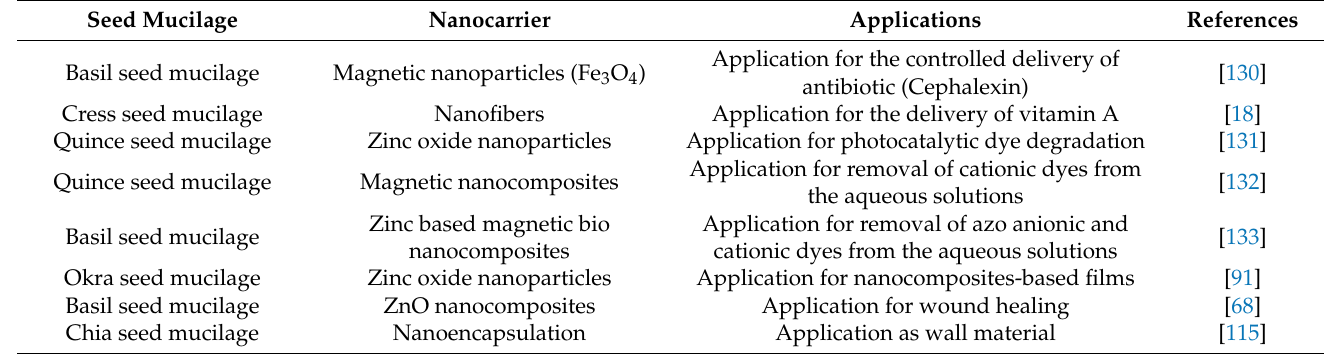
Table 5. Application of seed mucilage with various